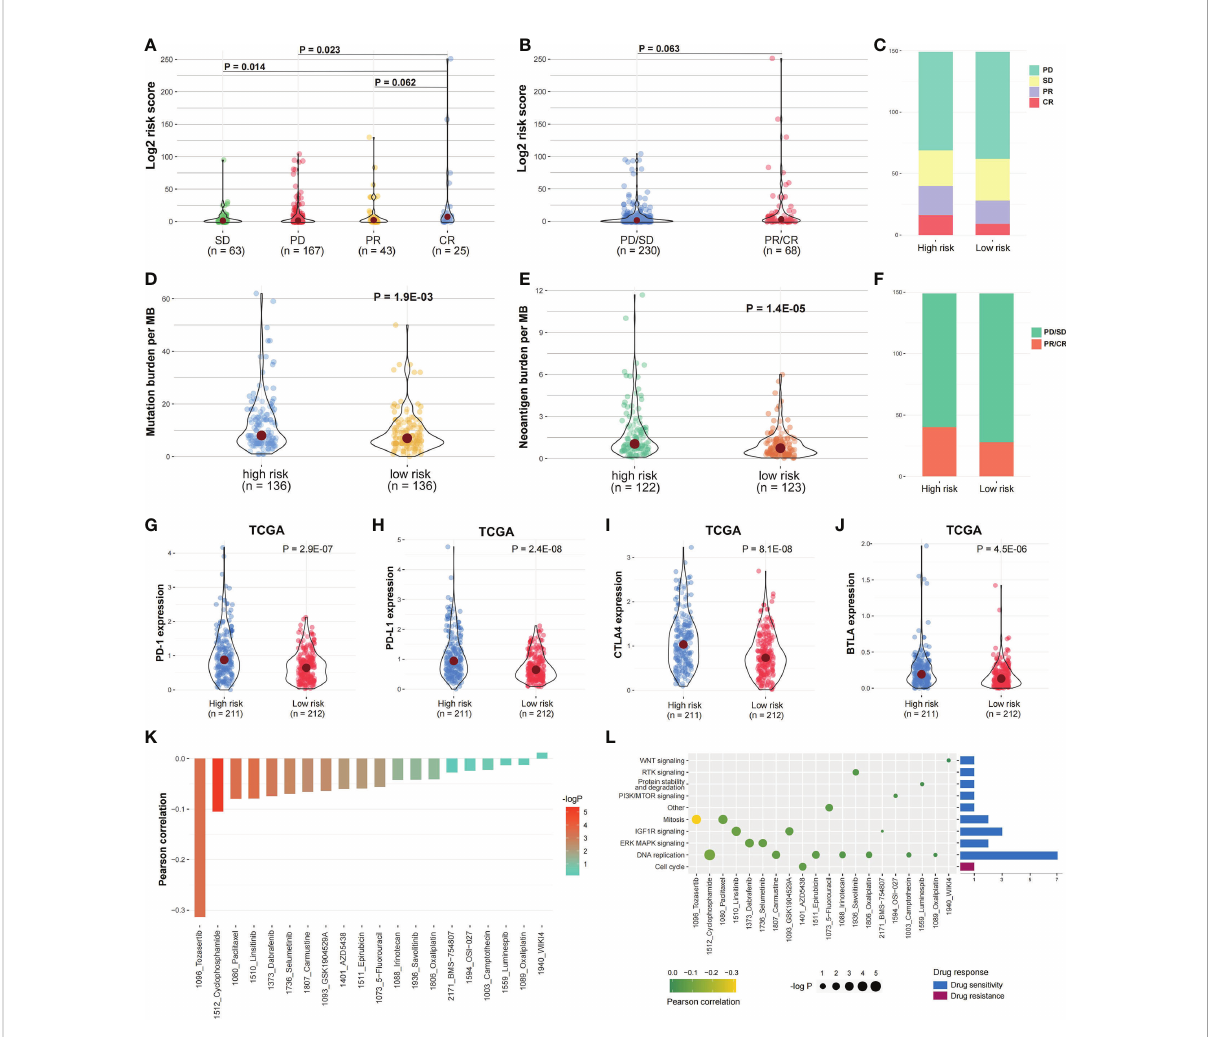
FIGURE 10 Risk score and drug response correlation. (A, B) In IMvigor210 cohort, the risk score distribution between the responsive groups and (C, F) between the two risk groups. (D, E) The mutation and Neoantigen burden distribution in the two risk group patients. (G – J) The immune checkpoints expression among the two risk groups. (K) The risk score and drug response value correlation using Pearson correlation analysis. Each column refers to a drug. Column brightness represents correlation signi fi cance. The column height represents a correlation. (L) Signaling pathways targeted by drug resistance to the risk score or sensitivity are presented in red and blue, respectively. Drug names and the signaling pathway targeted by the drug are presented on horizontal and vertical axes, respectively. The number of drugs targeting every signaling pathway is shown on the right of the bar graph. The point size represents the correlation signi fi